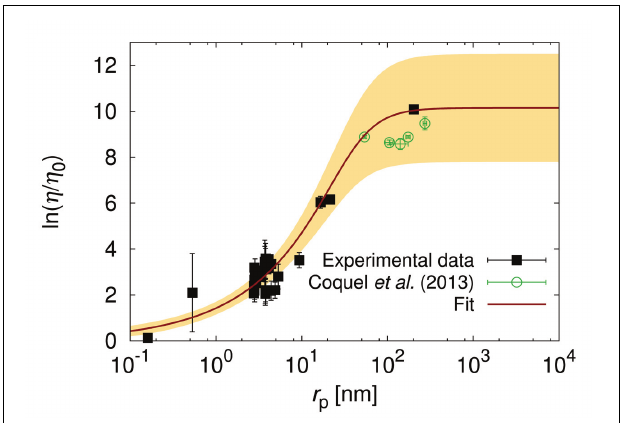
FIGURE 5 | The logarithm of the effective relative viscosity ( η/η 0 = D 0 / D ) experienced by the probe particles in the cytoplasm o E. coli . Plot shows the literature data for the reciprocal of diffusion coefficients [12, 13, 65–71, 73–77] (black pints), the fit of Equation (5) to the data, and the data of Coquel et al. [78]. The yellow shaded area corresponds to the maximal error of fitting. The plot is adopted from Kalwarczyk et al. [15] with a permission granted under the Creative Common license v3.0. The new data points obtained by Coquel et al. [78] are marked in green. D 0 is the diffusion coefficient in water of viscosity η 0